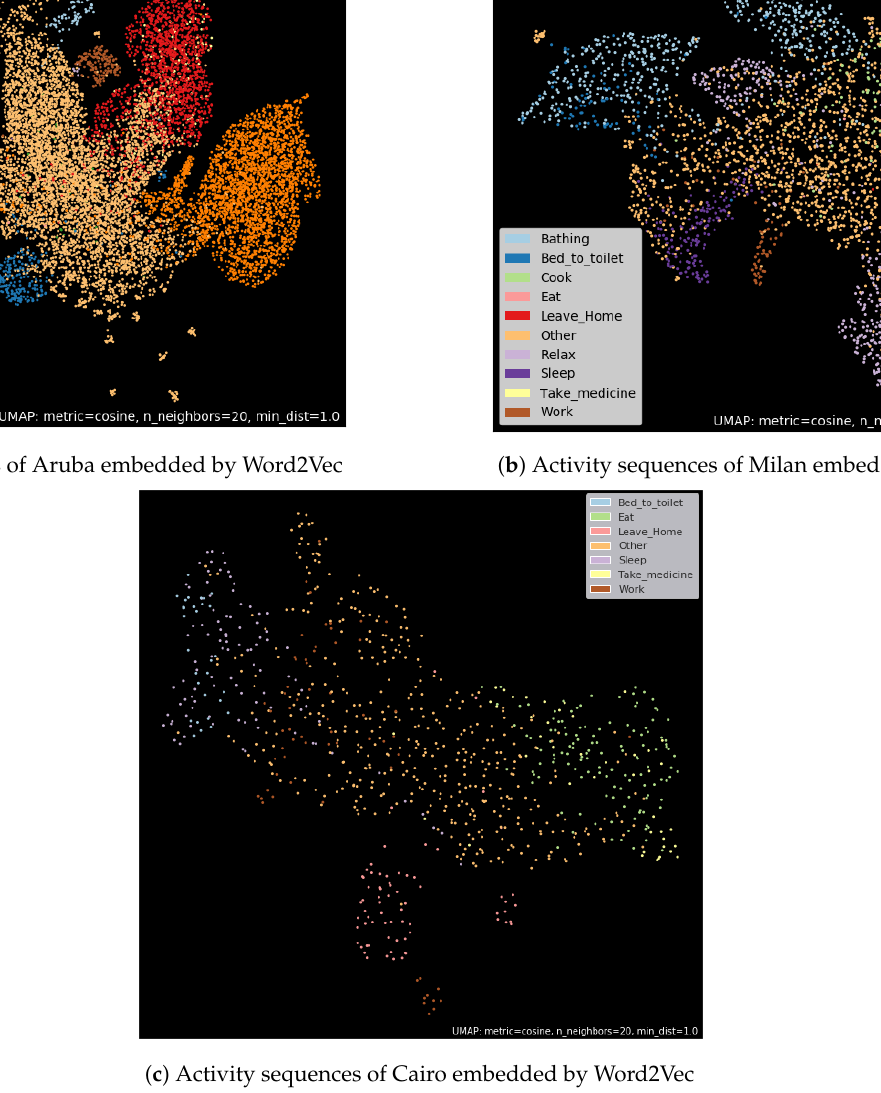
Figure 7. Word2Vec activity sequences